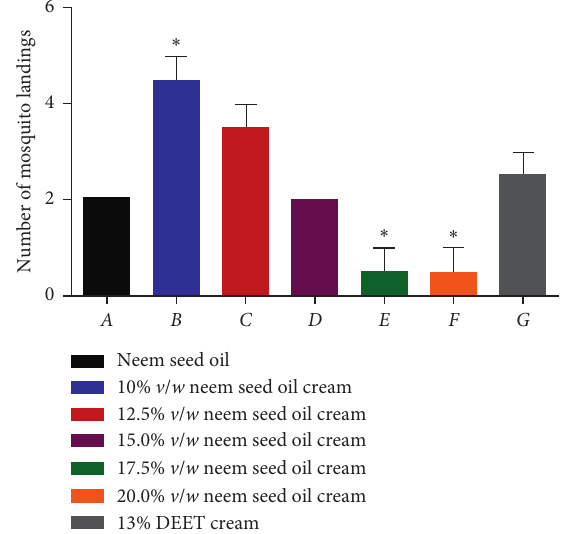
Figure 4: Number of mosquito landings on various concentrations of the neem seed oil cream after three minutes. ∗ Values are sig- nificantly different p ≤ 0 . 05 as compared with the reference drug